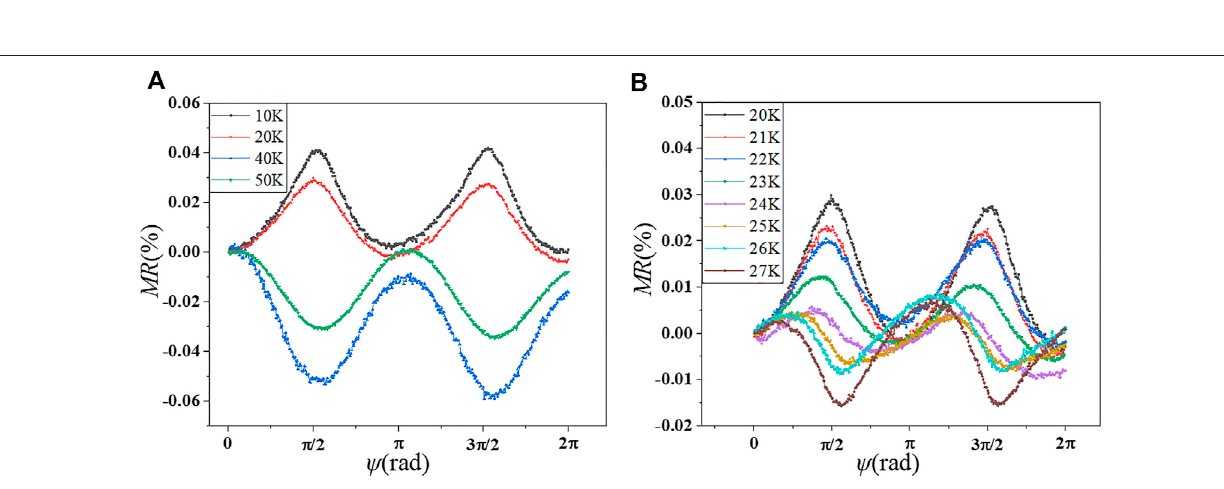
Frontiers in Physics |